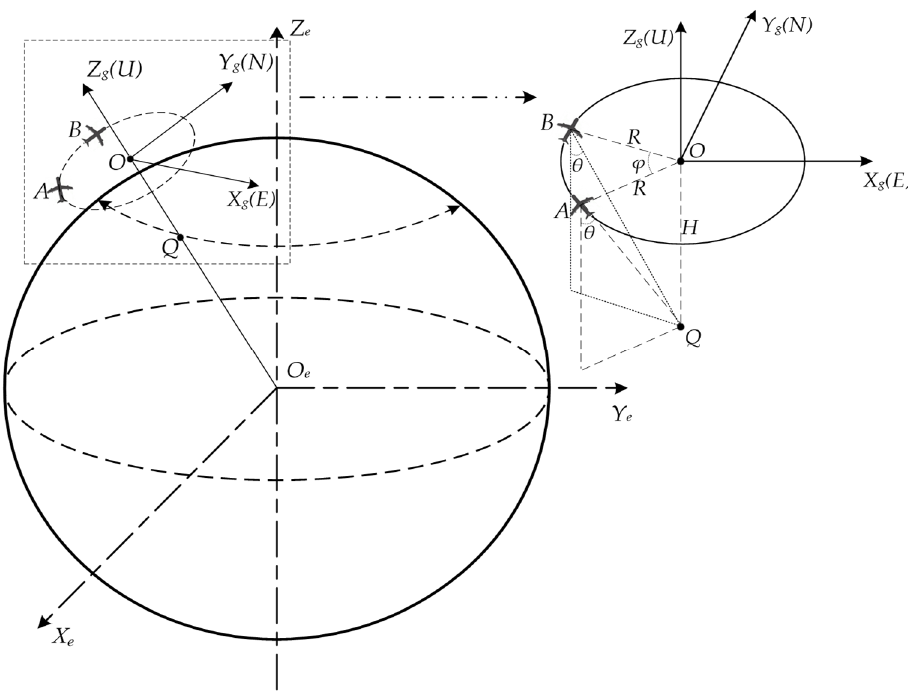
Figure 2. Dual aircraft geometric configuration.